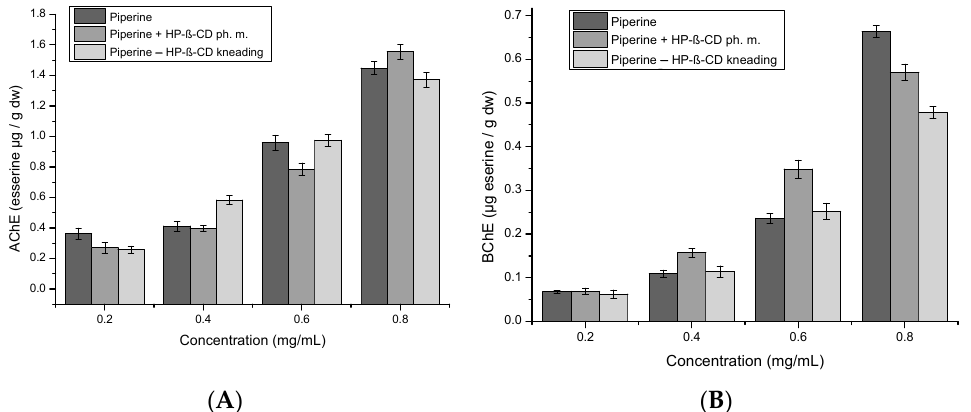
Figure 9. The activity of piperine, piperine mixture with HP- β -CD and physical mixture as AChE ( A ) and as BuChE inhibitors ( B ).